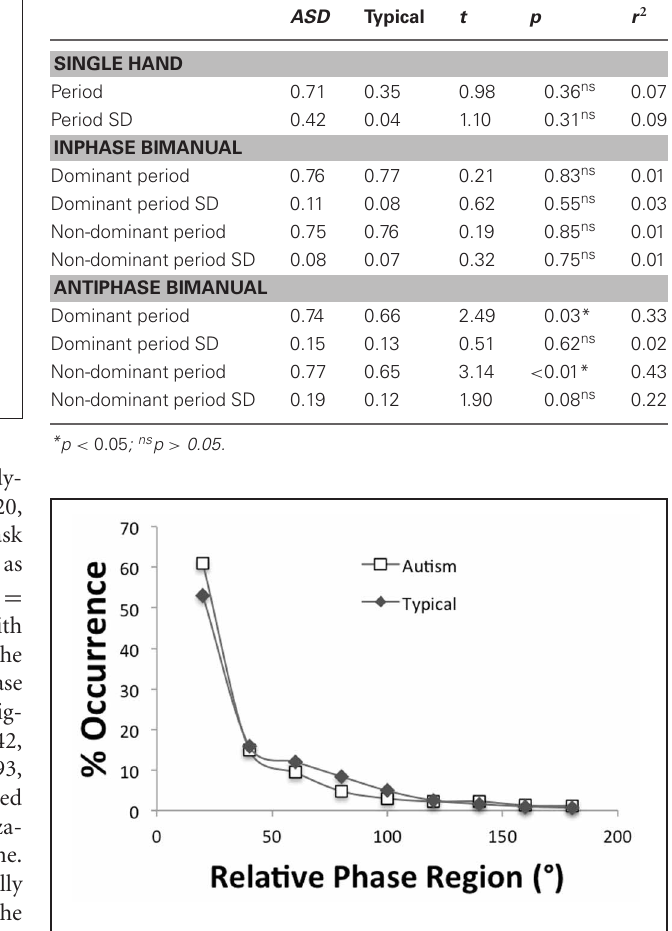
FIGURE 4 | Distributions of relative phase for inphase